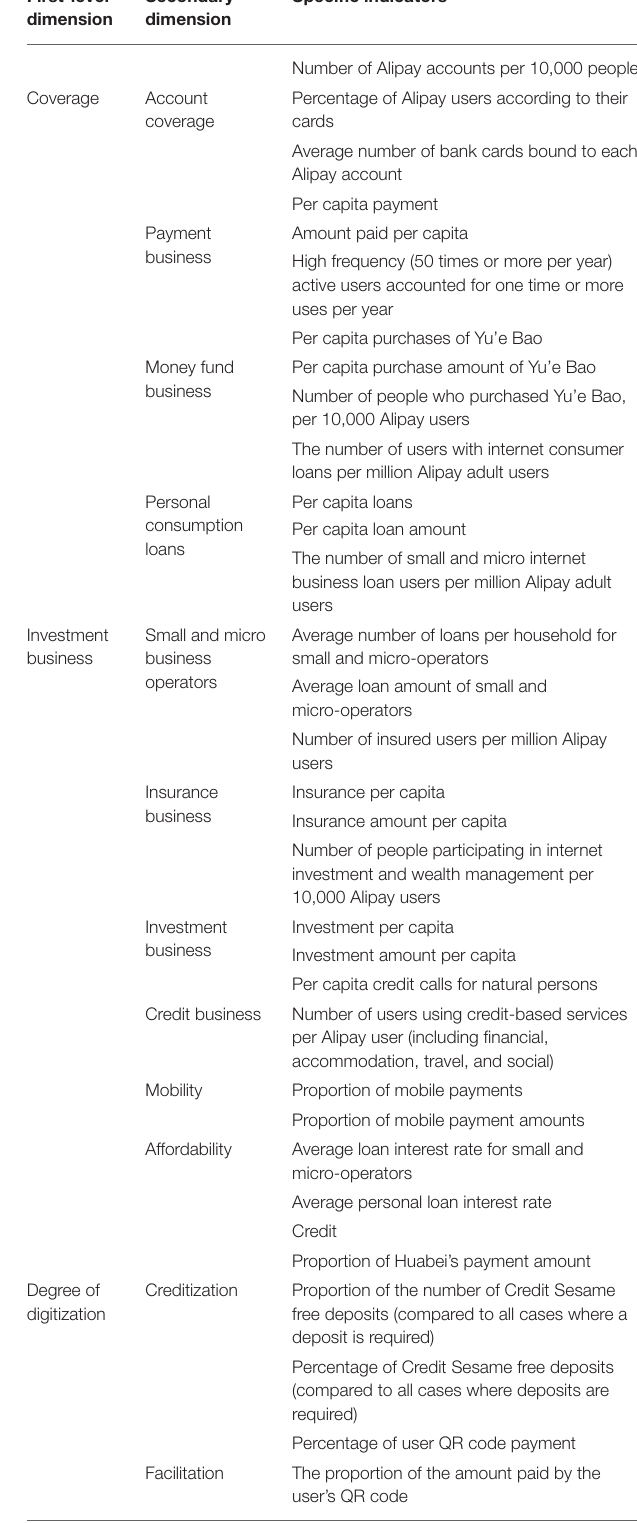
TABLE 1 | Digital economy index